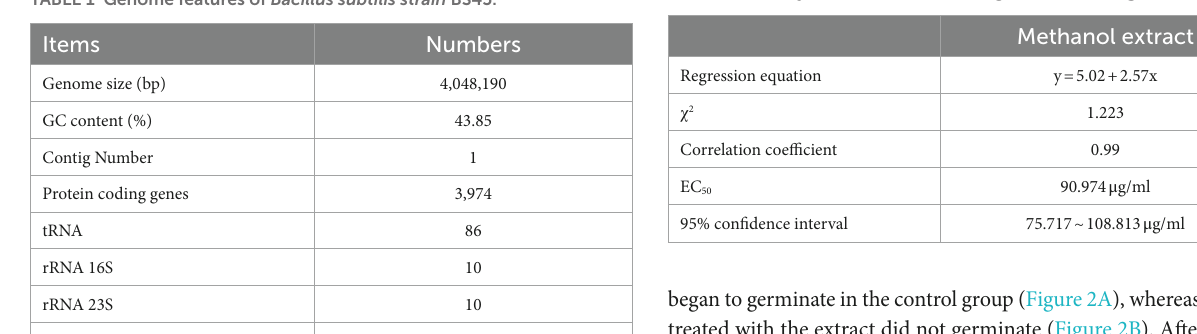
TABLE 1 Genome features of Bacillus subtilis strain BS45. TABLE 2 Toxicity of methanol extracts against Fusarium